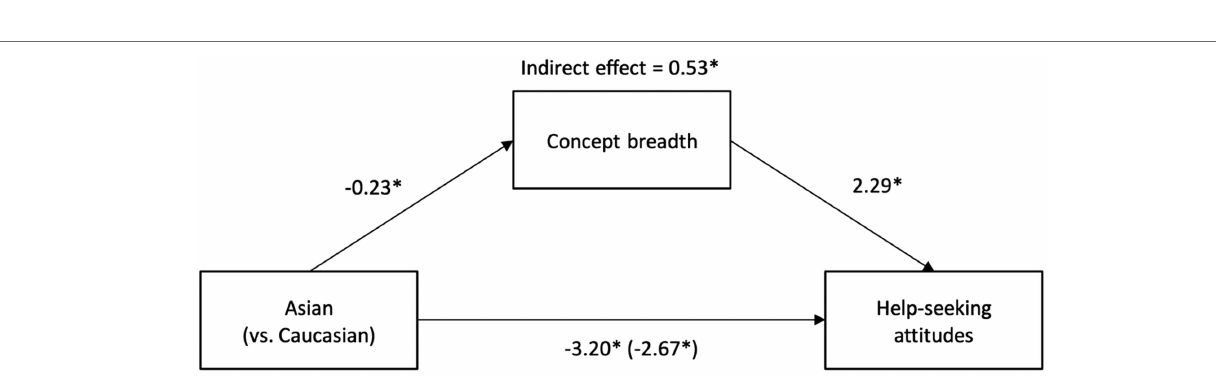
FIGURE 1 | Mediation model with social distance as the mediator. Unstandardized regression coefficients for the relationship between group (Asian American: n = 102; White American: n = 110) and help-seeking attitudes as mediated by social distance. The unstandardized regression coefficient between group and help- seeking attitudes controlling for social distance is in parentheses. Indirect effect of social distance on the relationship from bootstrap analyses ( n = 10,000). * p < 0.05.